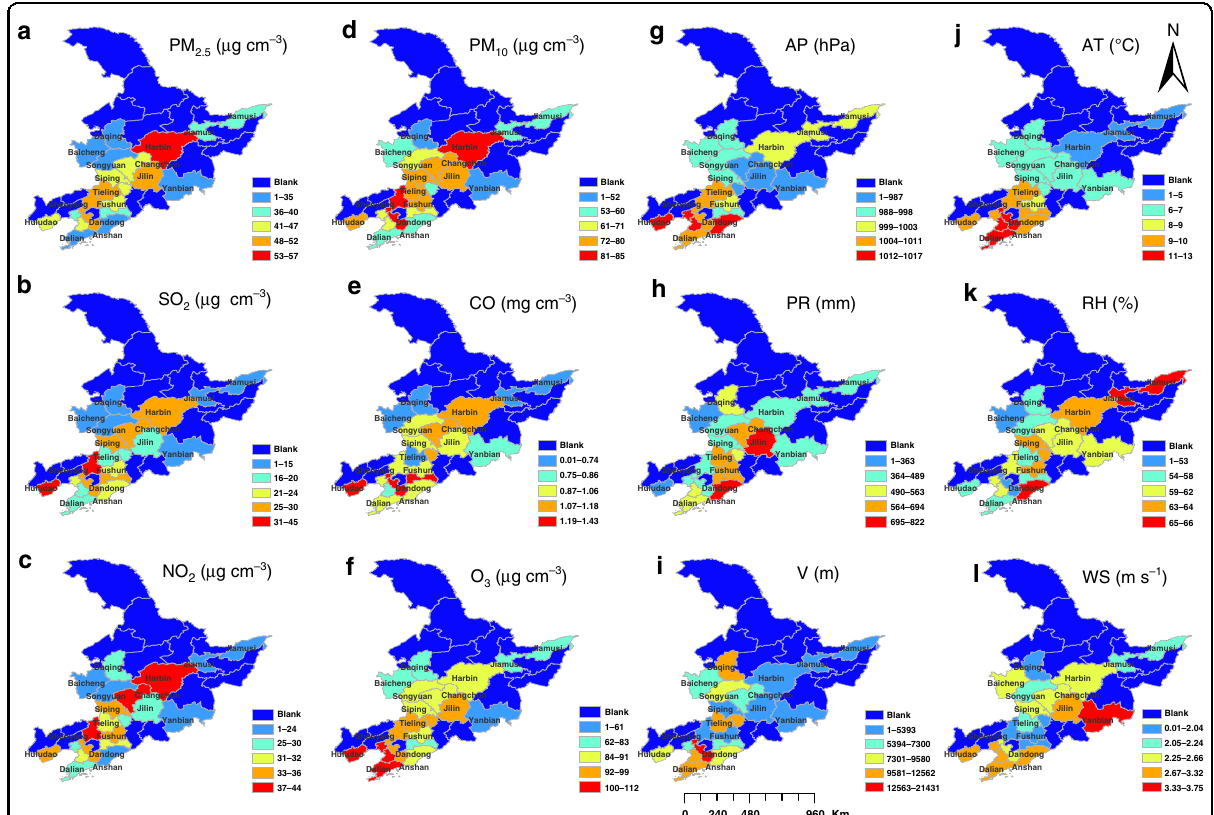
Fig. 3 Spatial distributions of annual concentrations of atmospheric pollutants. a – f and annual average or cumulative values (i.e., precipitation) of meteorological factors g – l in 2017. AP Air pressure, AT Air temperature, RH Relative humidity, V Visibility, PR Precipitation, WS Wind